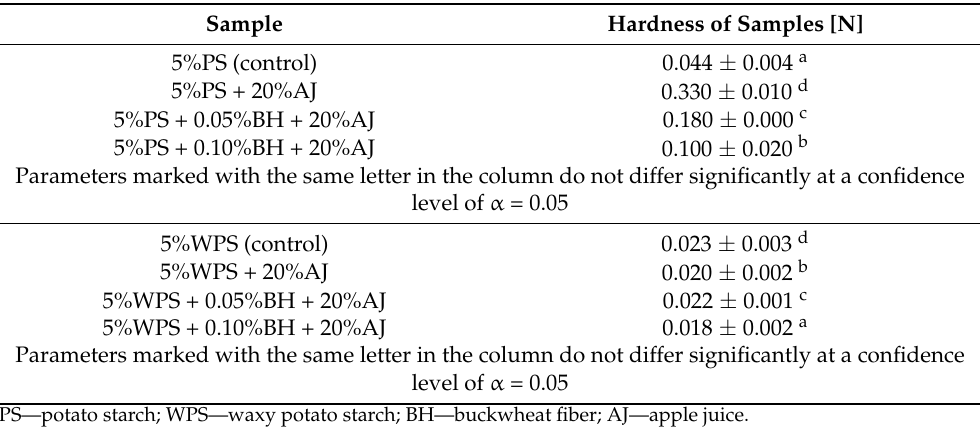
Table 5. Hardness of fruit gels with corn starch and buckwheat fiber.